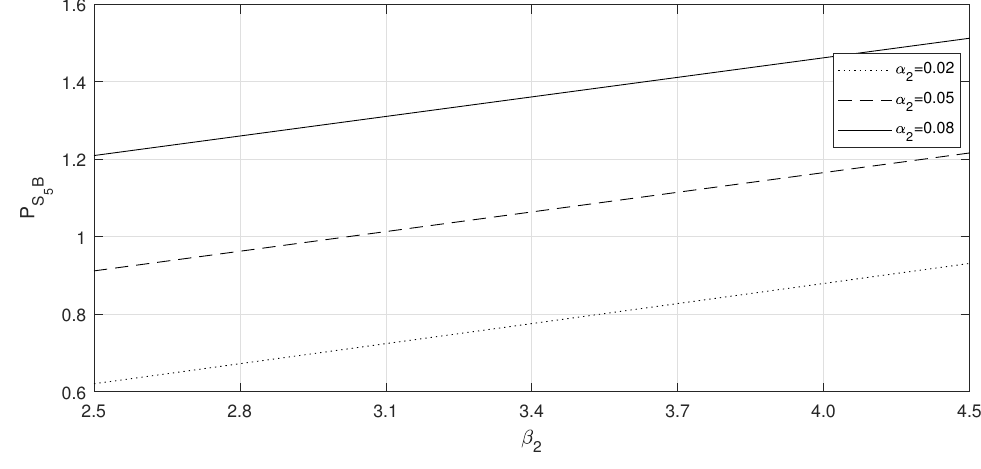
Figure 6. Probability that Server-5 is busy on α 2 vs. β 2 .